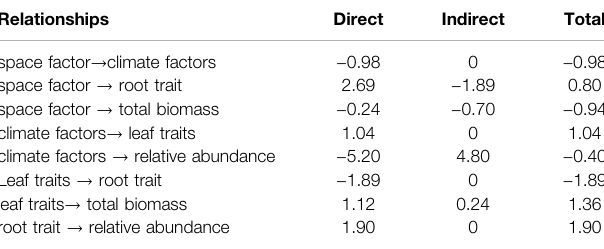
TABLE 4 | The path coef fi cients in the partial least squares path modeling (PLS- PM) model. Only paths among latent variables connected signi fi cantly were